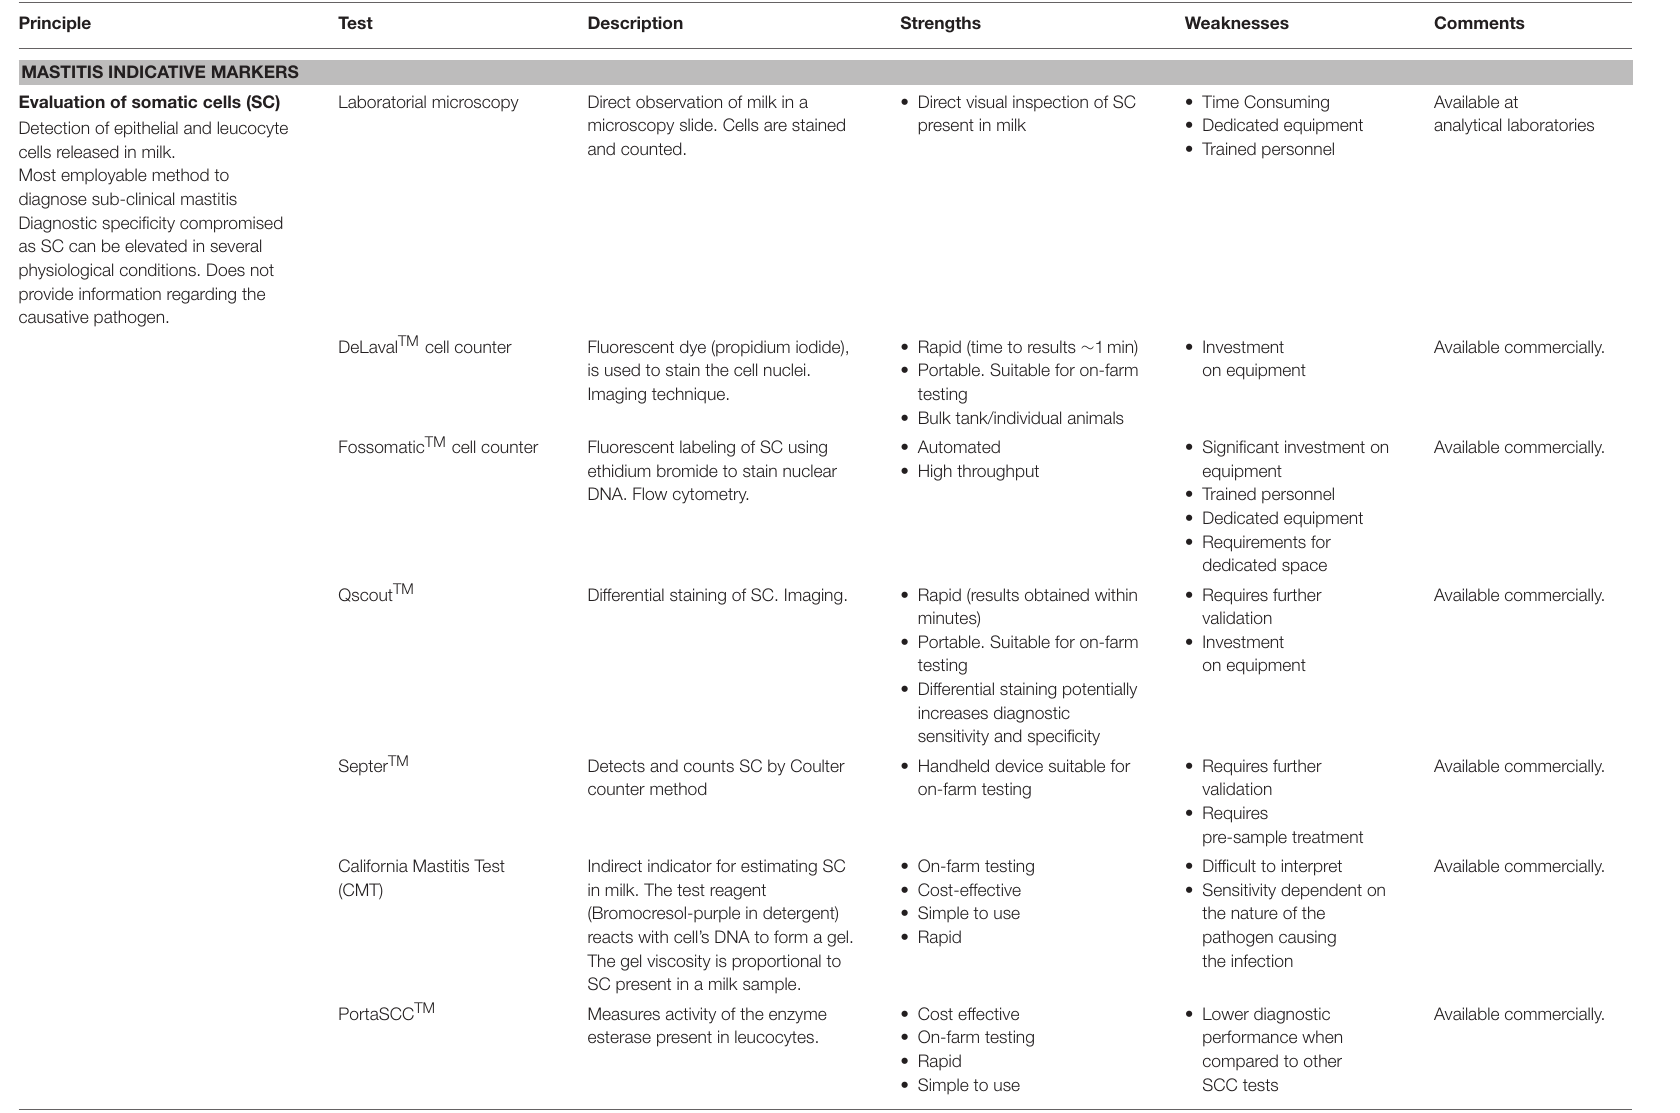
TABLE 1 | Summary of diagnostic methods for mastitis indicative markers and pathogens.